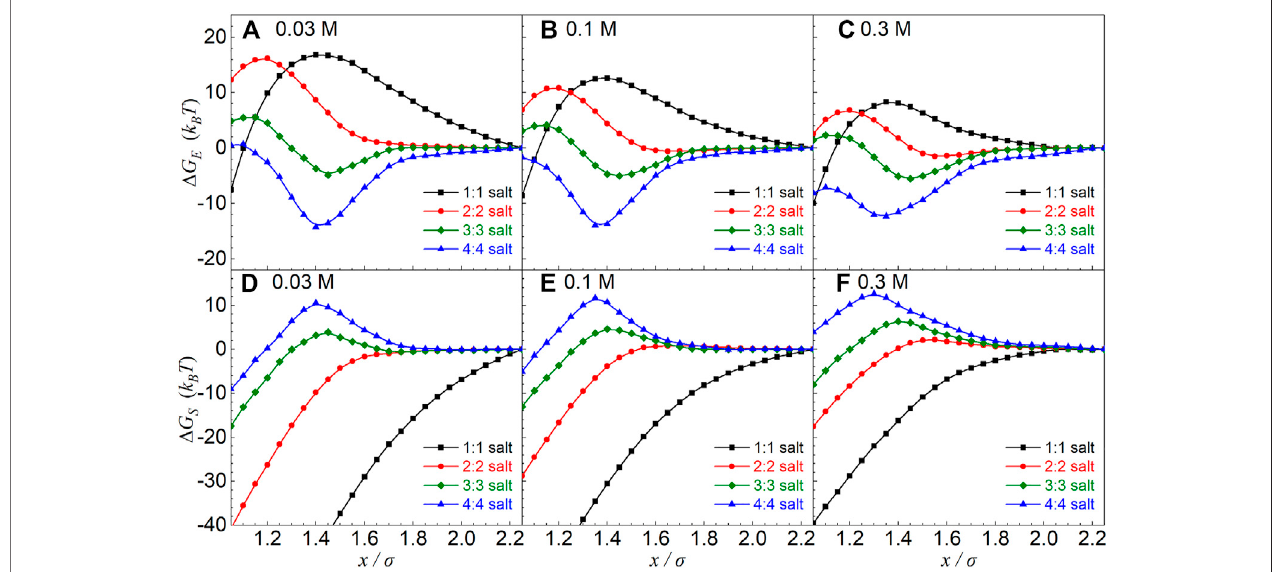
FIGURE 5 | (A – C) Electrostatic energy Δ G E and (D – F) entropic free-energy Δ G S as functions of separation x in symmetrical z:z salt solutions from the MC simulations.Theparticle chargeis|Z| (cid:1) 36e.Thesaltconcentrationsand ionvalenceshave beenshown intherespectivepanels. Thereferenceseparationwastakenas x ref (cid:1) 45